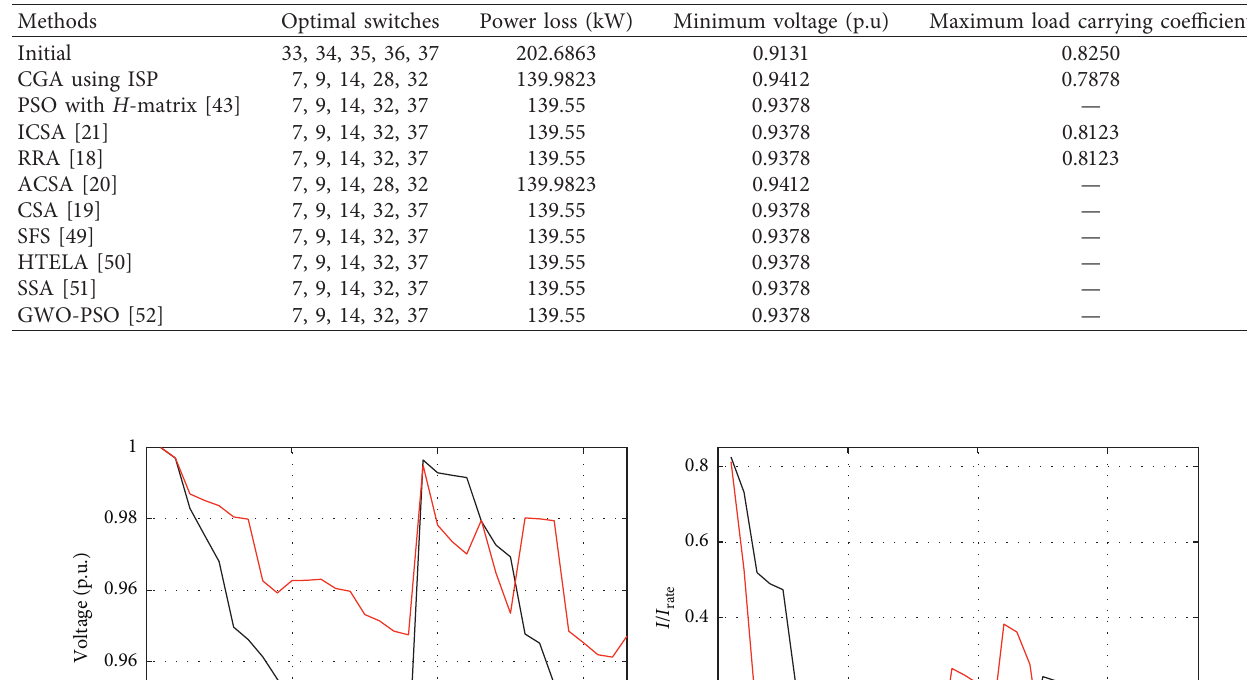
Table 3: Comparison results among proposed method CGA using ISP with different methods for the 33-node system.